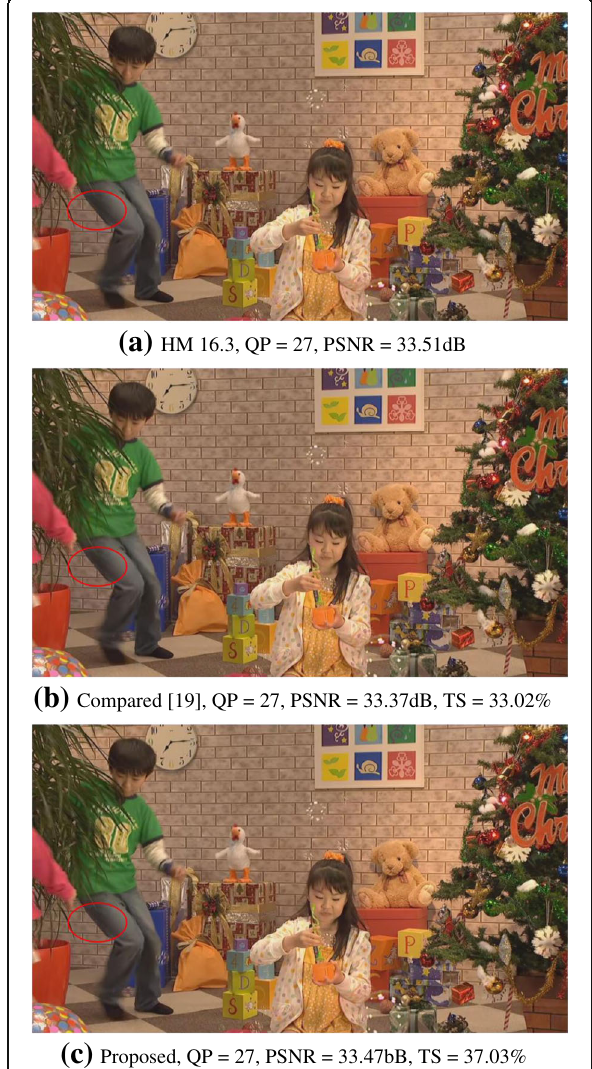
Fig. 17 Subjective comparison of S10 (PartyScene) under random-access configuration. ( a ) HM 16.3, QP = 27, PSNR = 33.51 dB. ( b ) Compared [19], QP = 27, PSNR = 33.37 dB, TS = 33.02%. ( c ) Proposed, QP = 27, PSNR = 33.47 dB, TS =